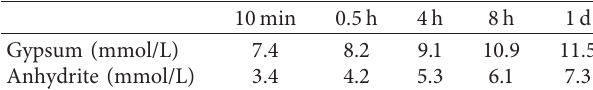
Figure 1: XRD spectra of two kinds of calcium sulfate resources: (a) gypsum and (b) anhydride. Table 1: Dissolution rate of two kinds of calcium sulfate in sat- urated lime